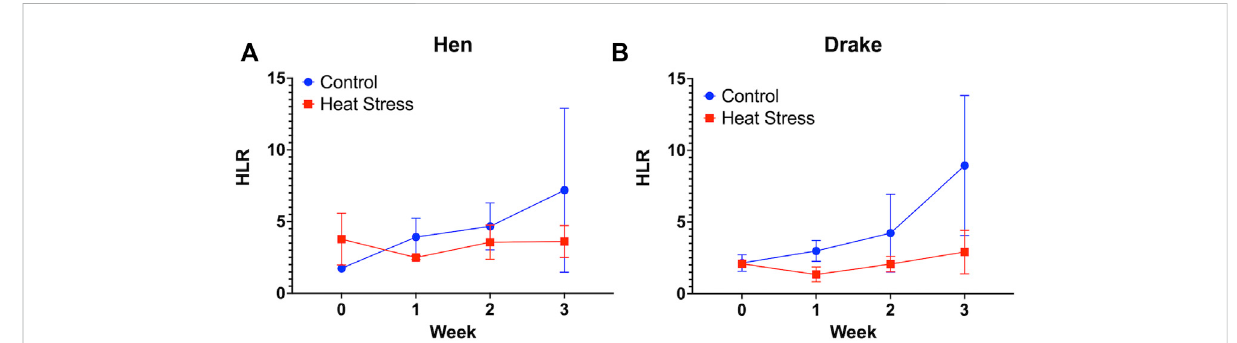
FIGURE 2 Heterophil and Lymphocyte ratio in Hens (A) and Drakes (B) exposed to cyclic heat stress (35 ° C for 10h/day and 29.5 ° C for the remaining 14h/ day)orcontrol.Datashown aremeans±SEM, n =6/sex/treatment/week. Nosigni fi cantdifferencewereobserved intheHLRofbothdrake andhen, however elevated levels in both groups suggest a hypersensitivity to the handling